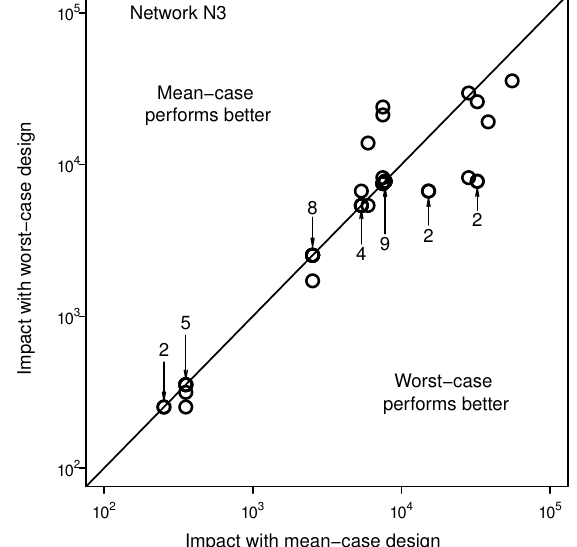
Figure 10. Comparison of worst-case impacts for transplanted mean- and worst-case CWS designs for Network N1 (numbers and arrows indicate overlapping or clustered points).